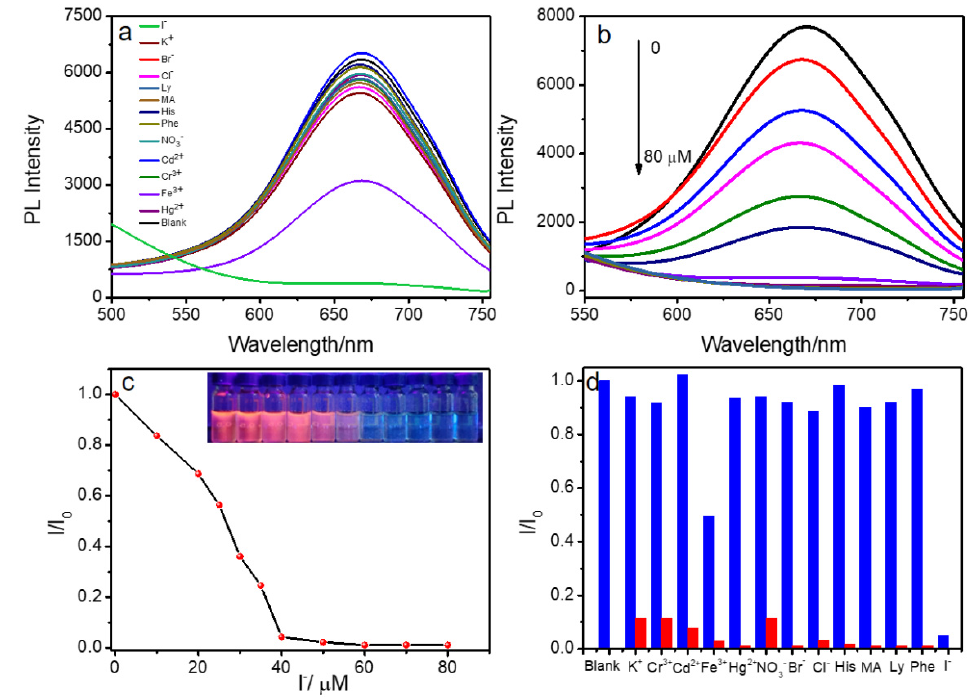
Figure 2. ( a ) PL spectra of CA/DPT-AuNCs with the addition of metal ions and small molecules (K + , Cr 3+ , Fe 3+ , Hg 2+ , Cd 2+ NO 3 − , Br − , Cl − , I − , His, MA, Ly and Phe c metal = 40 µ M, c small molecules = 40 μ M). ( b ) Concentration-dependent PL spectra of DPT-AuNCs with different c I − . ( c ) PL intensity at 670 nm of CA/DPT-AuNCs upon addition of various quantities of I − . ( d ) Selectivity of CA/DPT-AuNCs toward I − : Blue bars represent the addition of various small molecules or metal ions to CA/DPT-AuNC solution, and red bars represent the subsequent addition of I − ( c = 40 µ M) to the above solutions. Excitation wavelength is 390 nm.